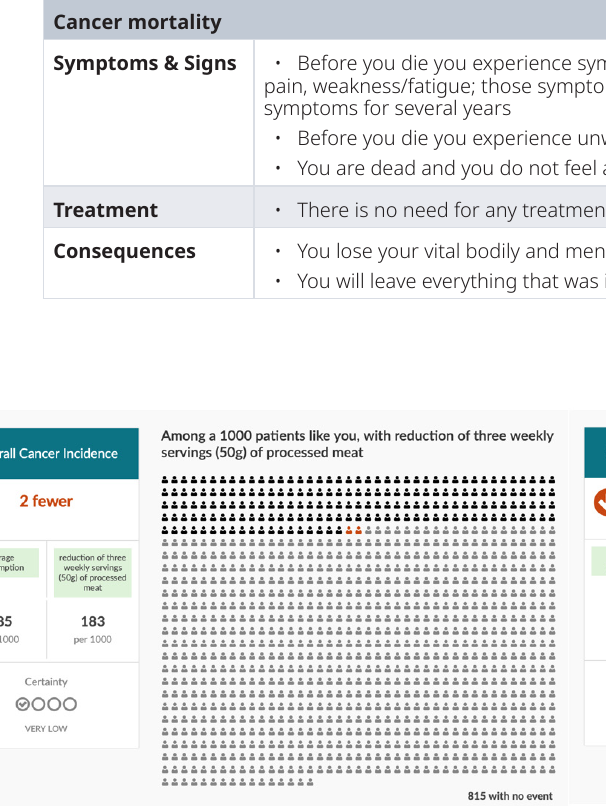
meat.Figure 1. Three servings/week scenarios for